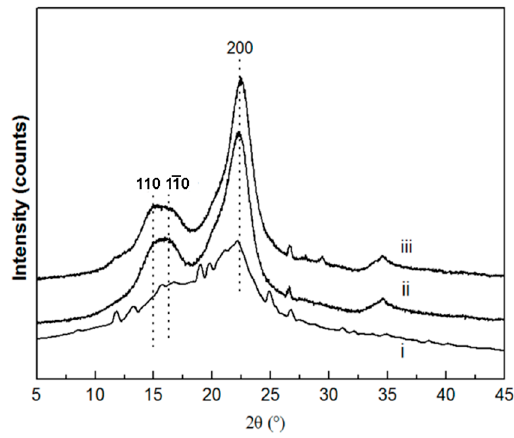
Materials 2017 , 10 , 80